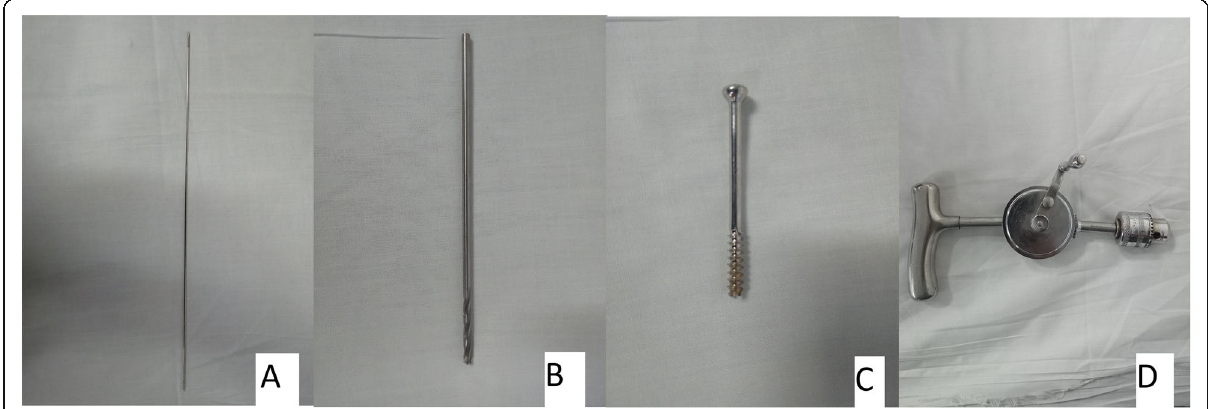
Fig. 1 Instruments set used in our series. a K-wire of 1.2 mm diameter with sharp tip. b Cannulated drill bit of 3.2 mm external diameter and 1.2 mm internal diameter. c Non-self-tapping partially threaded lag screw of 4 mm diameter with short head. d Hand